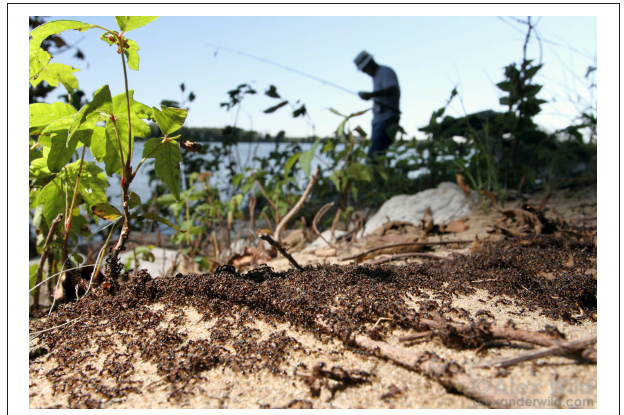
FIGURE 1 | Pavement ants, Tetramorium immigrans , are often encountered in urban and suburban areas throughout temperate North America. Here, workers from two colonies battle over territorial boundaries on the margins of a reservoir (Photo: Alex Wild).